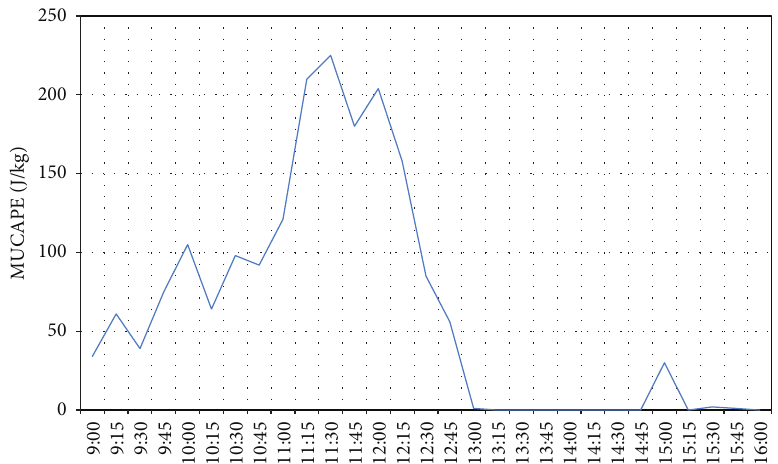
Figure 3: Evolution of MUCAPE index during February 1, 2013.